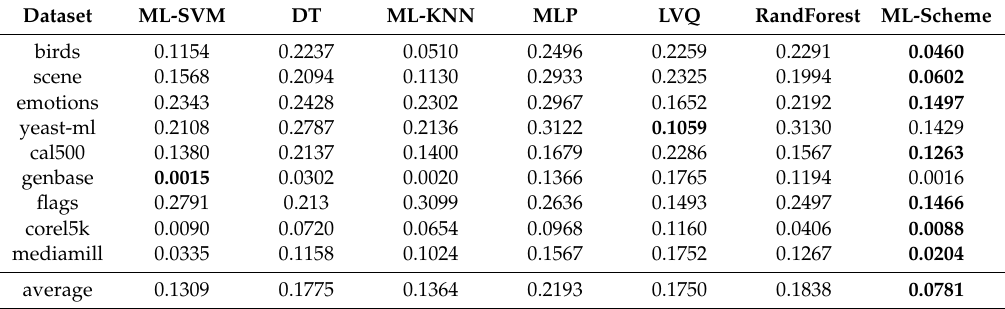
Table 4. Testing Hamming Loss (HL) obtained by di ff erent